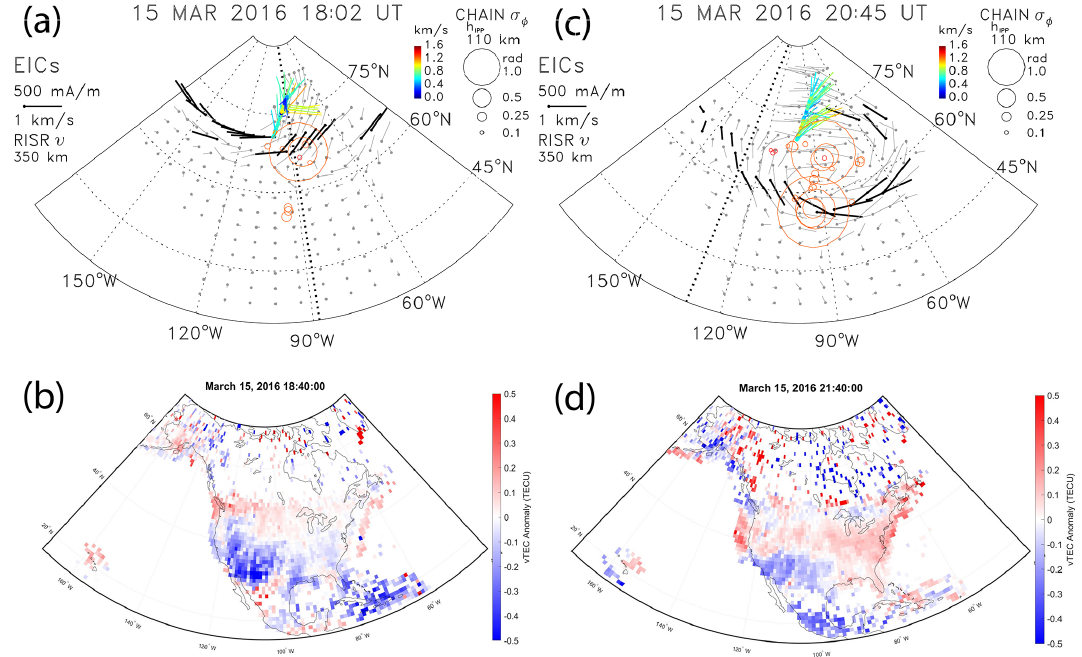
Figure 13. Panels (a–b) show the horizontal EICs with the latitudinal maxima at each longitude grid highlighted in bold and the CHAIN GPS IPPs with enhanced phase-variation values, σ (cid:56) (scaled circles). Panels (c–d) represent the detrended vTEC maps showing LSTIDs at later times on 15 March 2016.